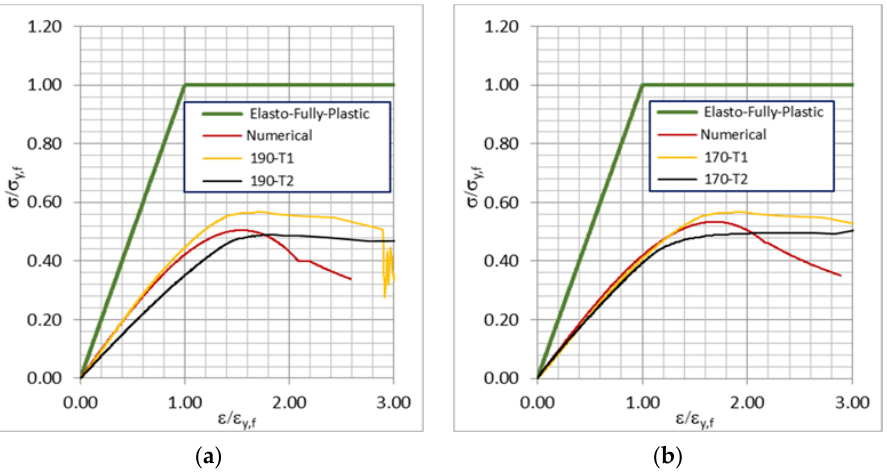
Figure 7. Stress–strain relationships of elastic ‐ fully plastic numerical and experimental results of specimens T1 and T2 for a span of 190 mm ( a ) and 170 mm ( b ).